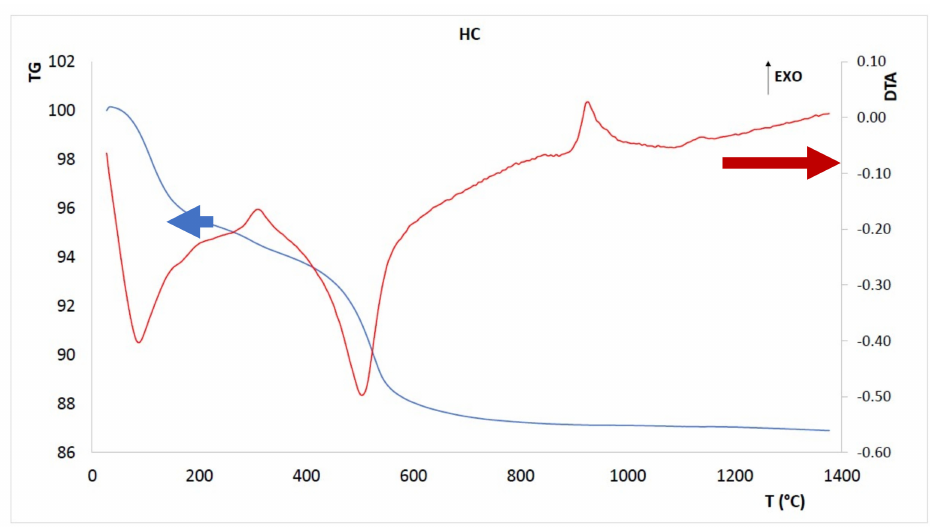
Figure 1. The halloysite clay before and after calcination.